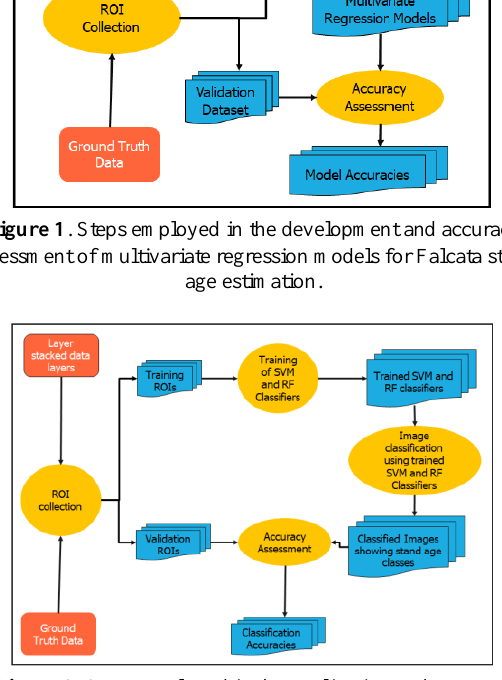
Figure 2 . Steps employed in the application and accuracy assessment of Support Vector Machine (SVM) and Random Forest (RF) classifiers for Falcata stand age estimation.